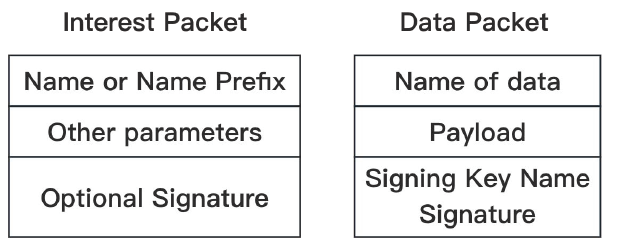
Figure 1. Two packets in